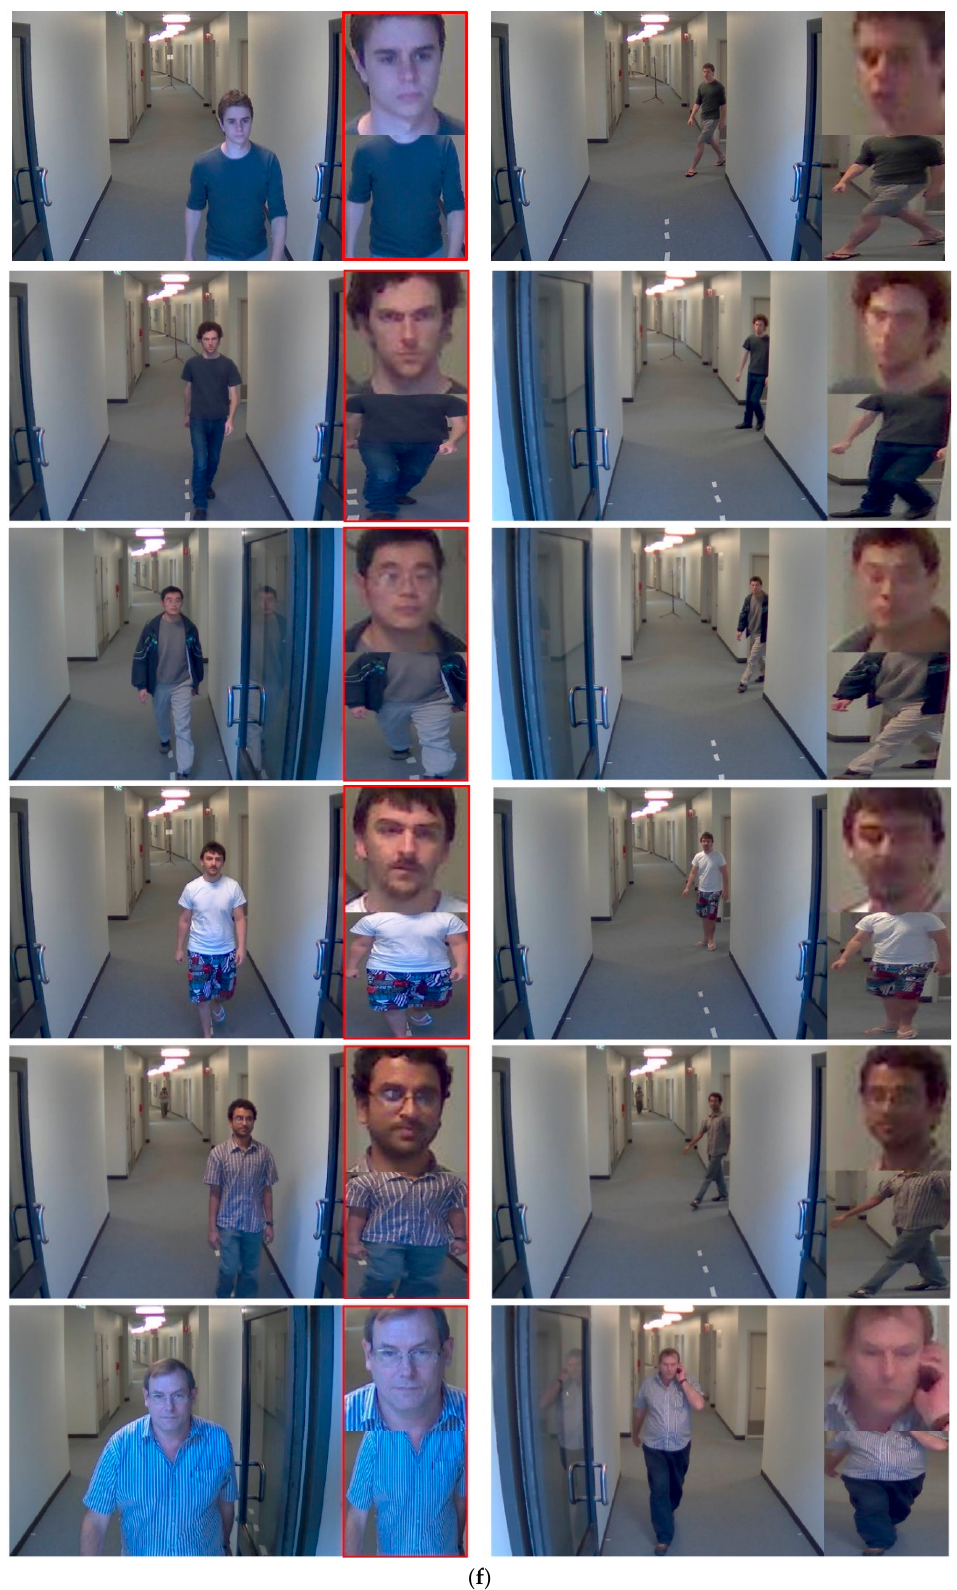
Figure 15. Cases of false acceptance (FA), false rejection (FR), and correct recognition. ( a – c ) cases from Dongguk face and body database (DFB-DB1), ( d – f ) cases from ChokePoint dataset. ( a , d ) FA cases. ( b , e ) FR cases. ( c , f ) cases of correct